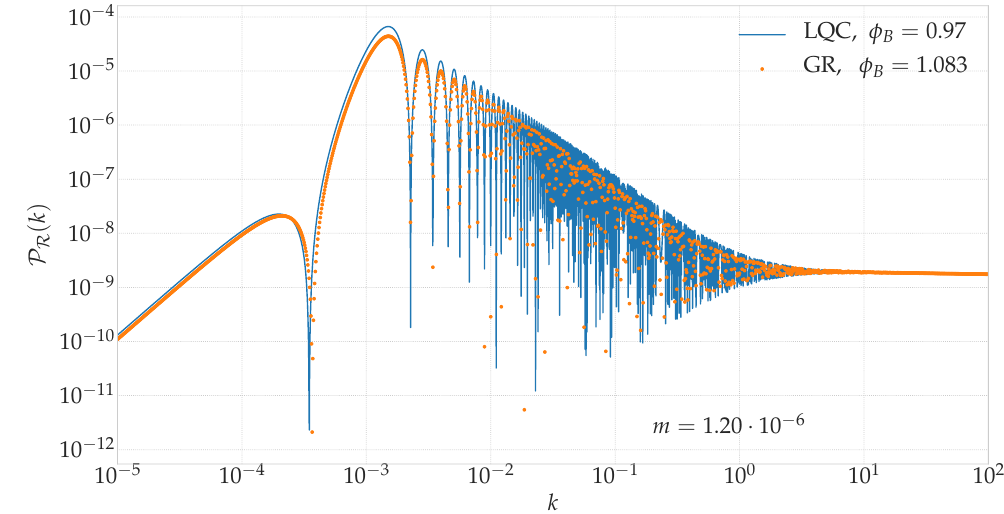
Figure 8. Primordial scalar power spectrum of the 0th-order adiabatic vacuum in hybrid LQC on the solution studied in Section 5, and in GR on the Einsteinian counterpart of that background. In this background, the inflaton at the time when the bounce occurs in LQC is φ B = 1.083 in Planck